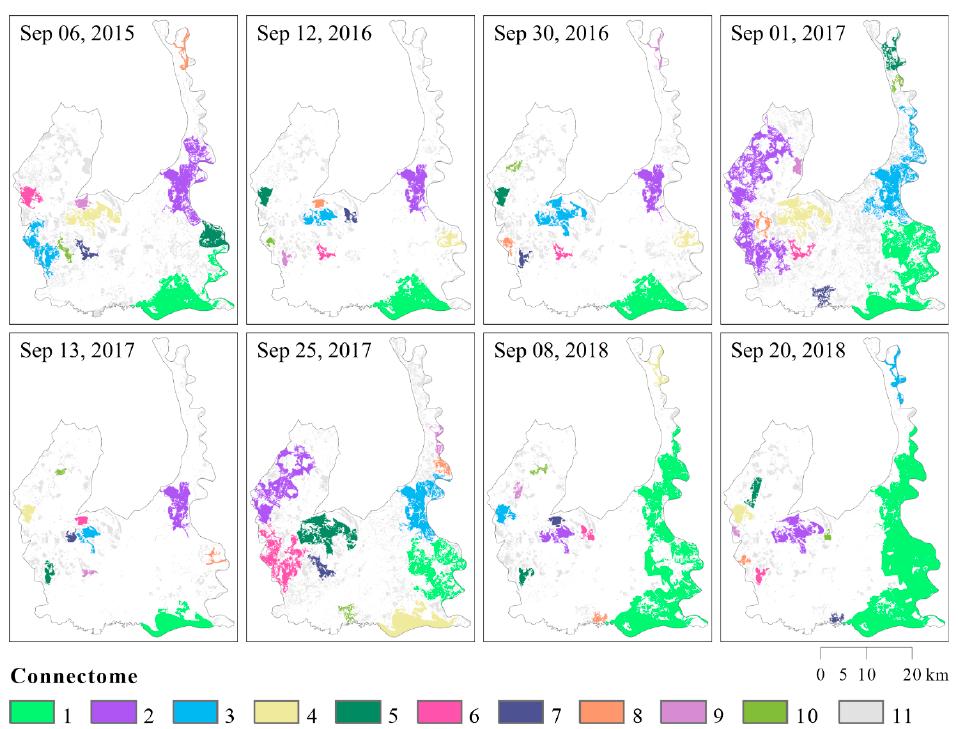
Figure 13. Spatial distribution of the connectomes (i.e., seasonally connected water bodies) in China’s Momoge National Nature Reserve in September. Colors 1 to 10 in the legend refer to the top ten largest connectomes, and color 11 refer to the remaining connectomes and isolated water bodies. Water 2020 , 12 , x FOR PEER REVIEW